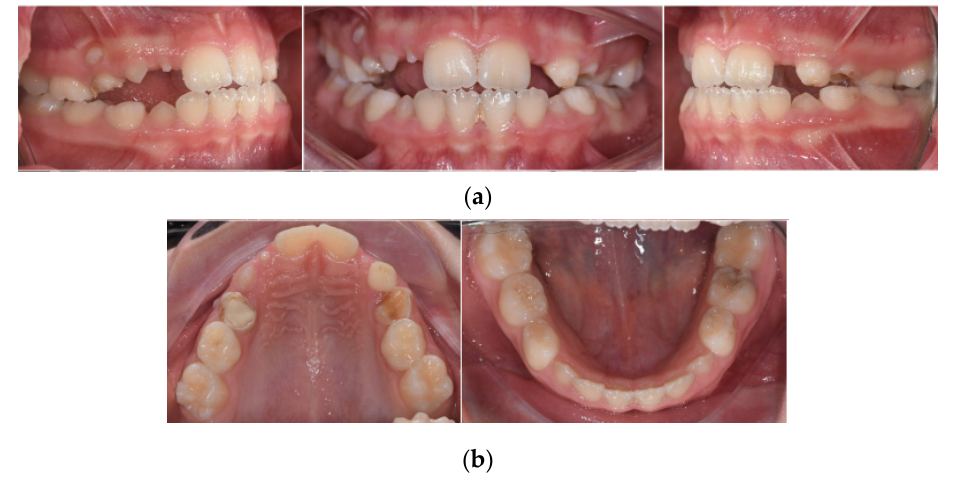
Figure 4. Intraoral clinical photographs, including views of: ( a ) anterior and posterior crossbite; ( b ) upper and lower arch.